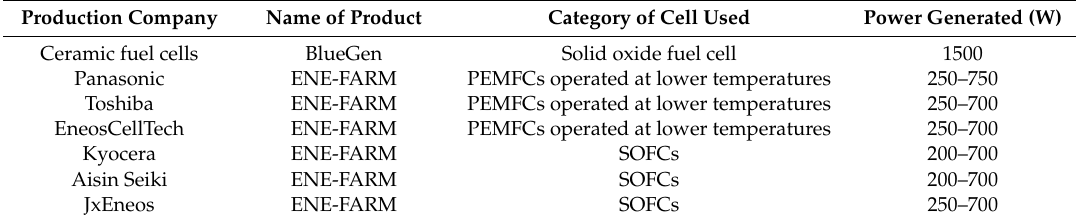
Table 2. Commercially available fuel cell combined heat and power [90].